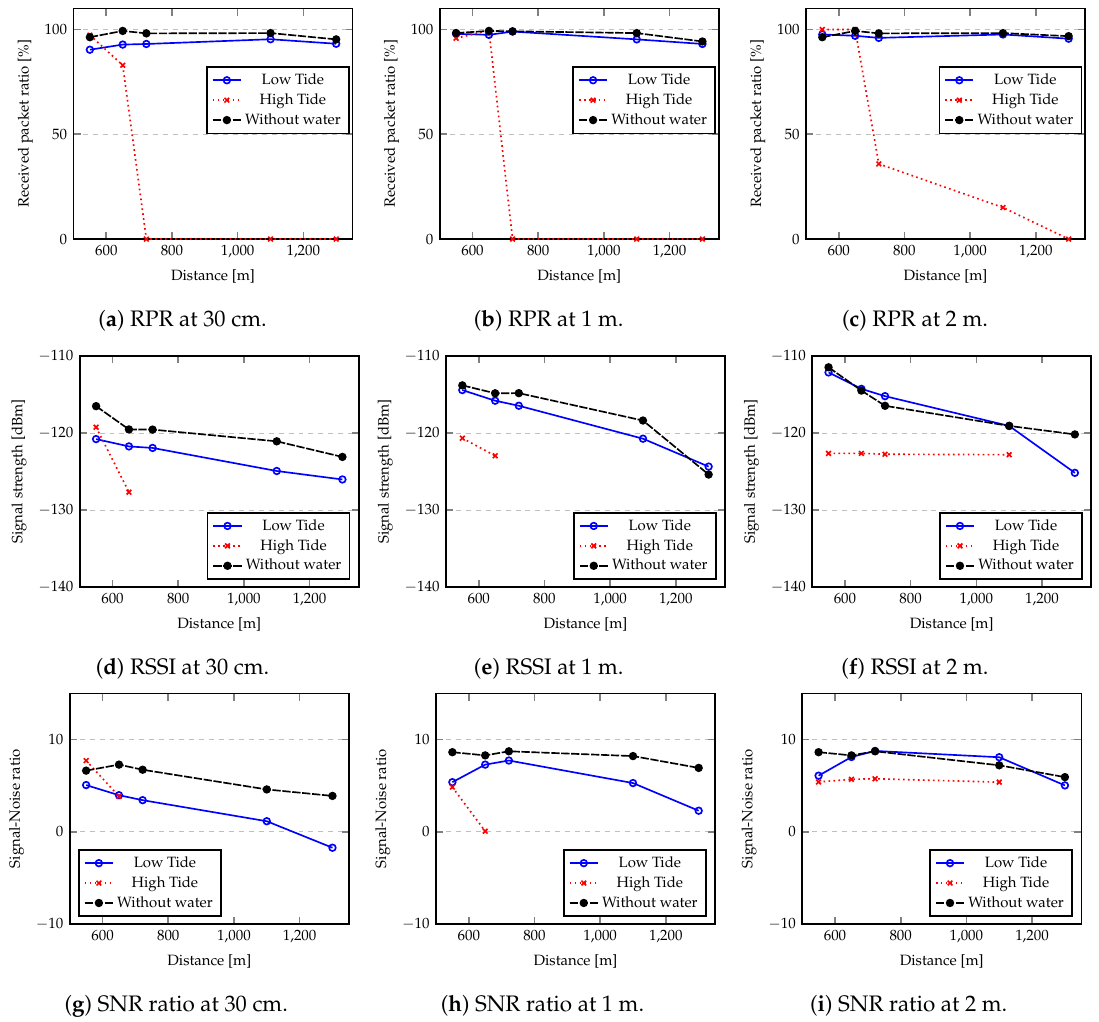
Figure 9. Received packet ratio (RPR), received signal strength indicator (RSSI) and signal-to-noise ratio (SNR) with nodes placed at 30 cm, 1 m and 2 m above water and above the ground (without